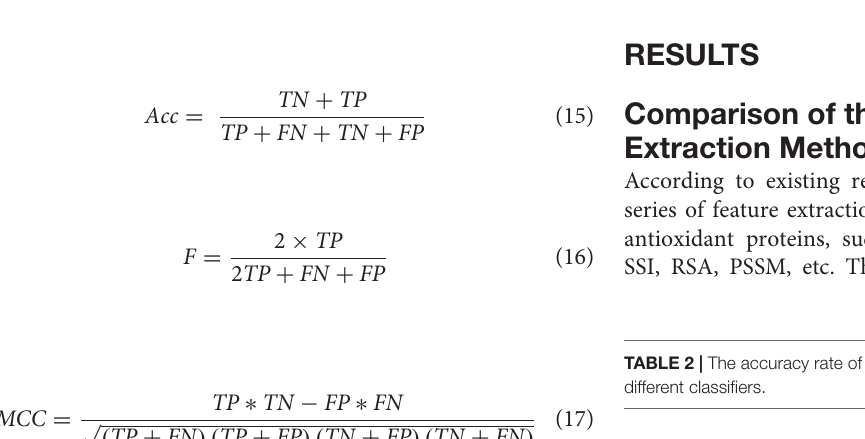
FIGURE 3 | (A) The comparison chart of the results. It was obtained by different feature extraction methods and it shows that the results of the evaluation indicators using the CKSAAP+CT method were higher than the other methods. (B) The average value of the final results obtained by using three types of unbalanced processing methods. The result obtained by oversampling is much higher than the other methods. It can be seen that repeated sampling of a small number of sample data to synthesize new data is more conducive to extracting features that make it easy to distinguish antioxidant proteins. (C) Comparison of classification effects before and after dimensionality reduction with MRMD. Sn, Sp, and Acc are greatly improved, and the Sn and Sp results are very balanced. (D) Compared with sequence characteristics of the antioxidant proteins and non-antioxidant proteins, the triplet of the first type amino acid and the second type amino acid combination appears more frequently.